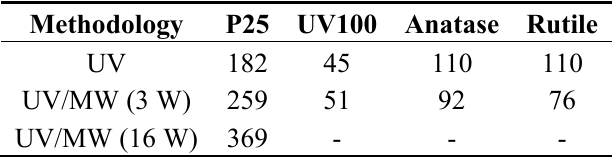
Table 2. Number of DMPO- • OH spin adducts produced in the various heterogeneous systems under microwave irradiation, UV irradiation, and MW/UV irradiation relative to those formed in the rutile TiO 2 specimen for the TiO 2 /H 2 O/MW heterogeneous system. Reproduced from [43]. Copyright 2003 by Elsevier B.V.